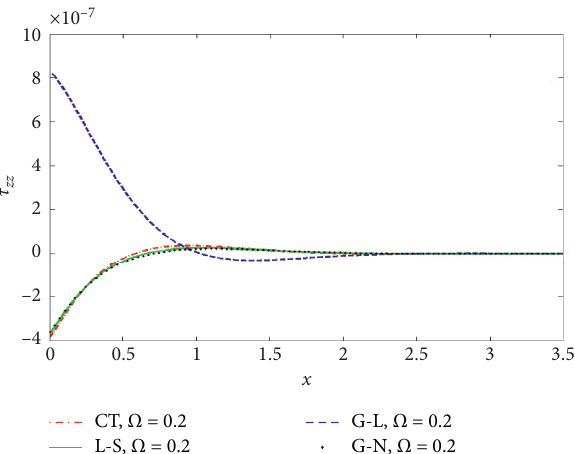
Figure 10: Horizontal displacement u concerning x under gravity and